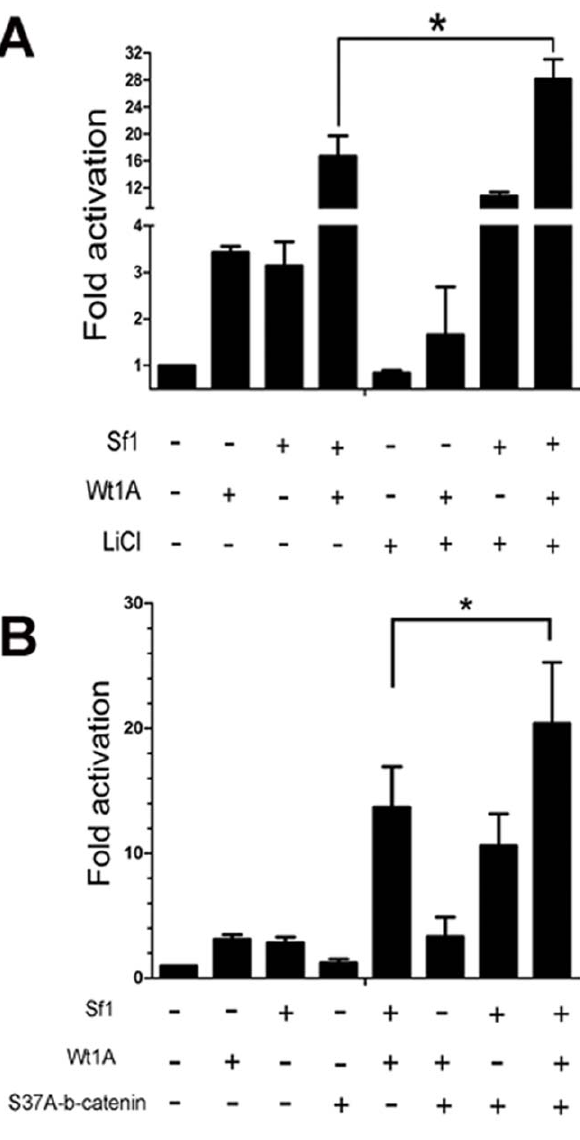
Figure 7. Synergistic activation of the inhibin- a promoter by Wt1 and Sf1 is enhanced by Wnt signaling, but the inhibin- a promoter is not synergistically activated by Wt1 and Wnt signaling. A, Compared to Wt1 and Sf1 co-transfected TM4 cells, co- transfection of constitutively activated b -catenin, S37A could signifi- cantly induced the luciferase activity. In contrast, S37A b -catenin alone did not promote the activity of inhibin- a promoter induced by Wt1 only. B, The same results were obtained when TM4 cells were treated with 40 mM LiCl treatment.